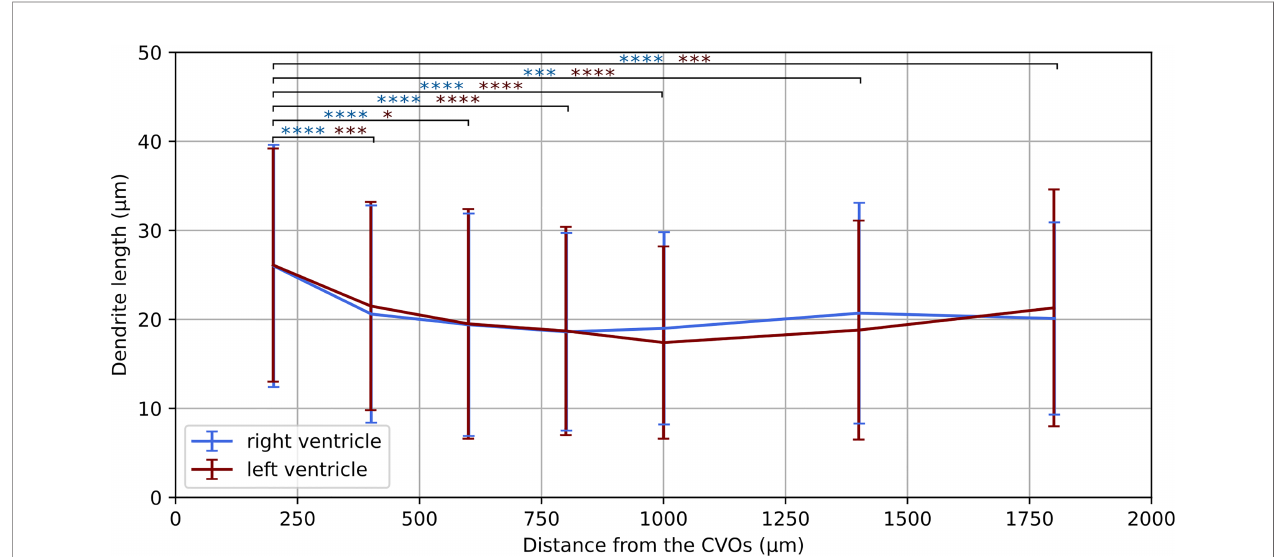
FIGURE 7 | Dendrite length at increasing distances from the CVOs. Average dendrite length in the right and left ventricles measured at increasing distances from the circumventricular organs (CVOs), respectively in light blue and dark red colour. The p-value for each sub-volume pair is colour-coded according the respective ventricle and presented with *p < 0.05, ***p < 0.001, ****p < 0.0001.